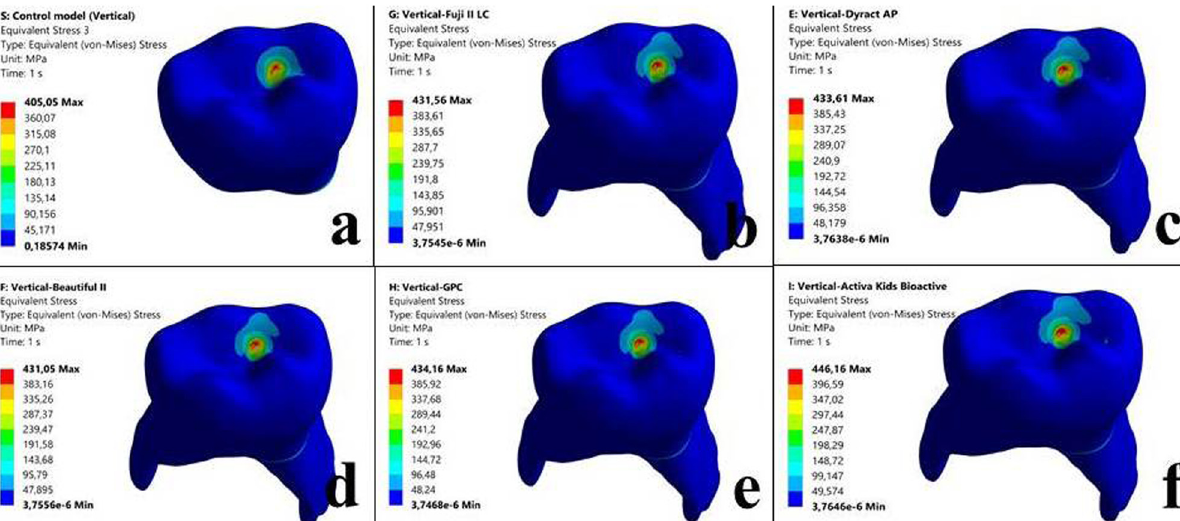
Figure 2: Distribution of Von Mises stress for models with vertical loading: ( a ) tooth model without restoration ( control group ) , ( b ) tooth model with Class I restoration ( resin - modi fi ed glass ionomer ) , ( c ) tooth model with Class I restoration ( compomer ) , ( d ) tooth model with Class I restoration ( giomer ) , ( e ) tooth model with Class I restoration ( glass carbomer ) and ( f ) tooth model with Class I restoration ( ionic resin material with bioactive properties ) .